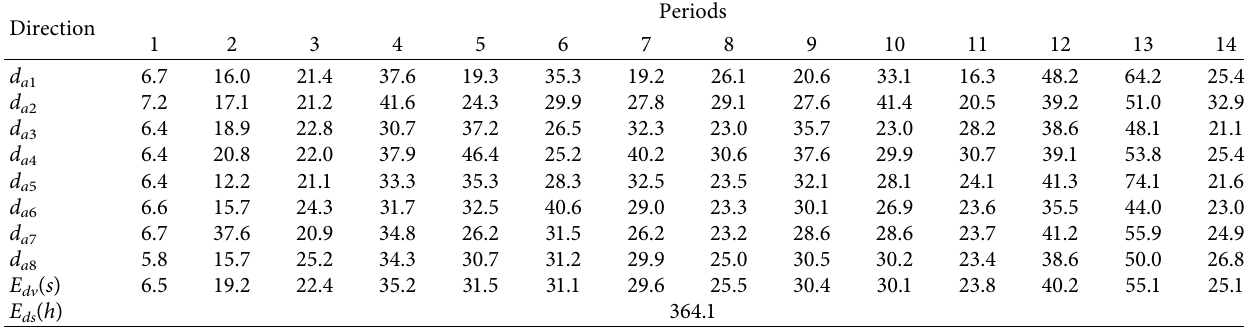
Table 12: Analysis results of the average vehicle delay in scheme